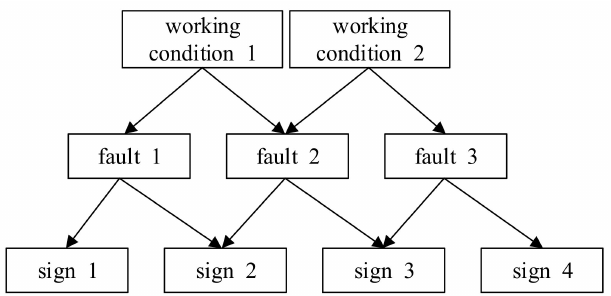
Figure 1. Structure of the Bayesian